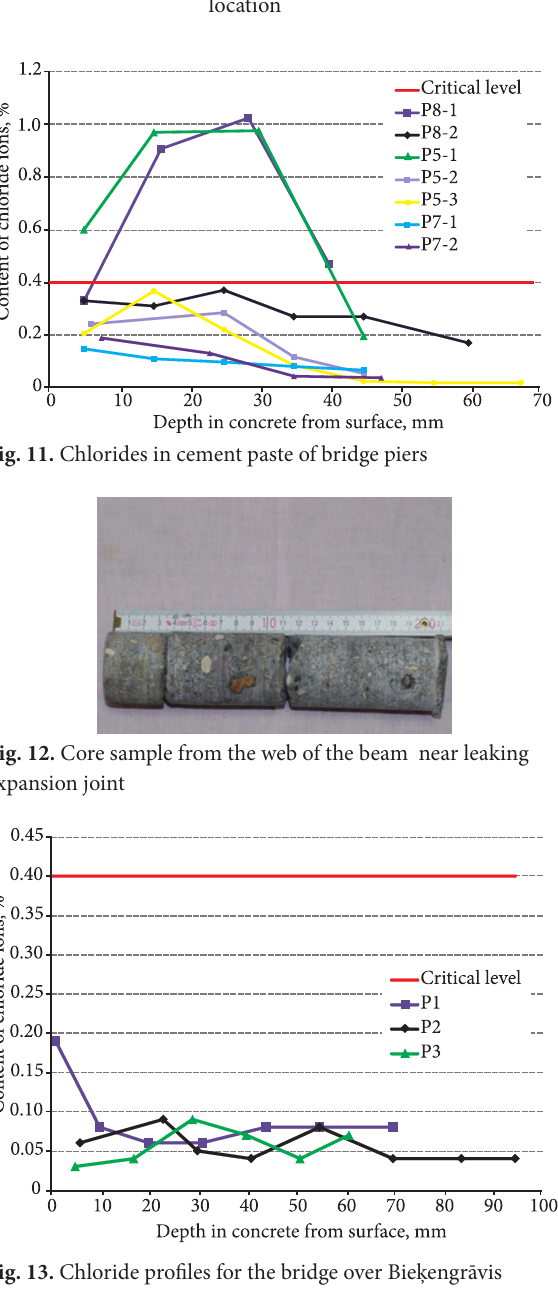
fig. 13. Chloride profiles for the bridge over